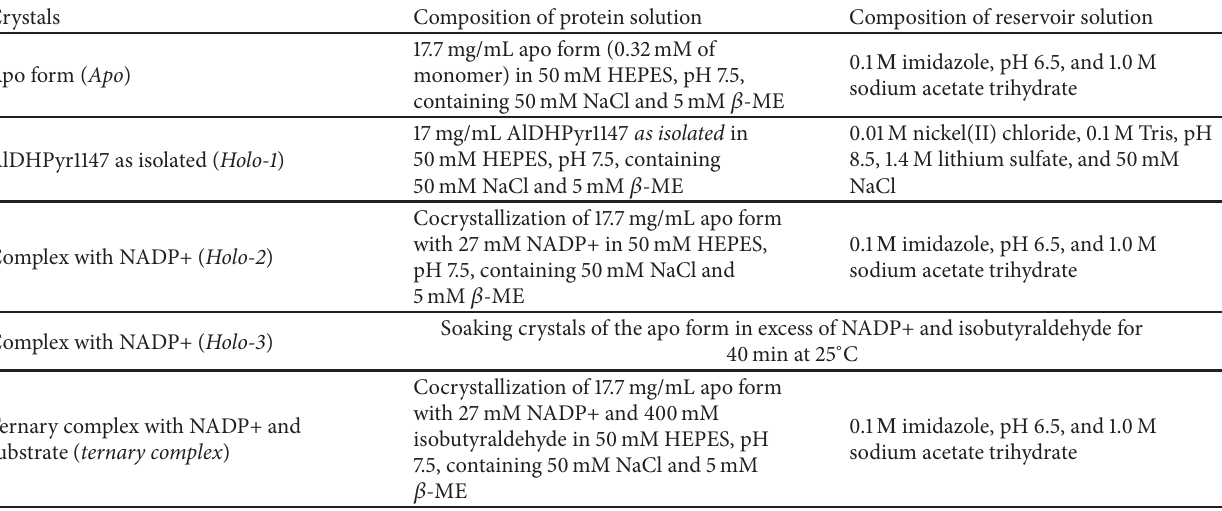
Table 1: Crystallization conditions for different models of